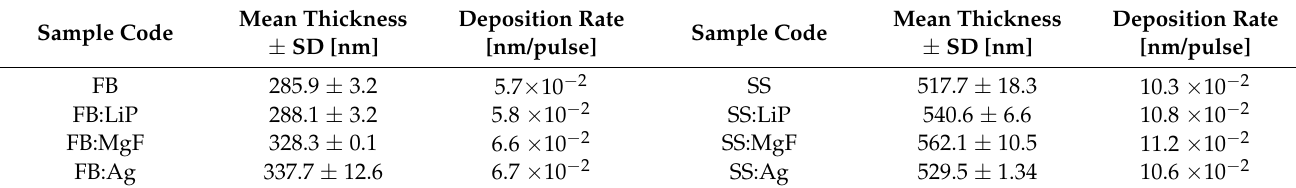
Table 2. Mean thicknesses and deposition rates of simple and doped FB and SS thin